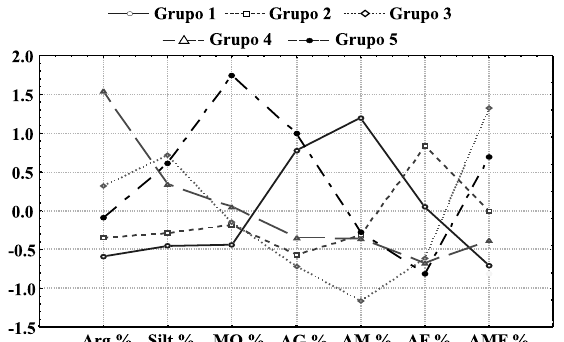
Figura 2. Gráfico do perfil de centroides de cada grupo formado a partir da percentagem das variáveis determinadas: argila (Arg), silte (Silt), matéria orgânica (MO), areia grossa (AG), areia média (AM), areia fina (AF) e areia muito fina